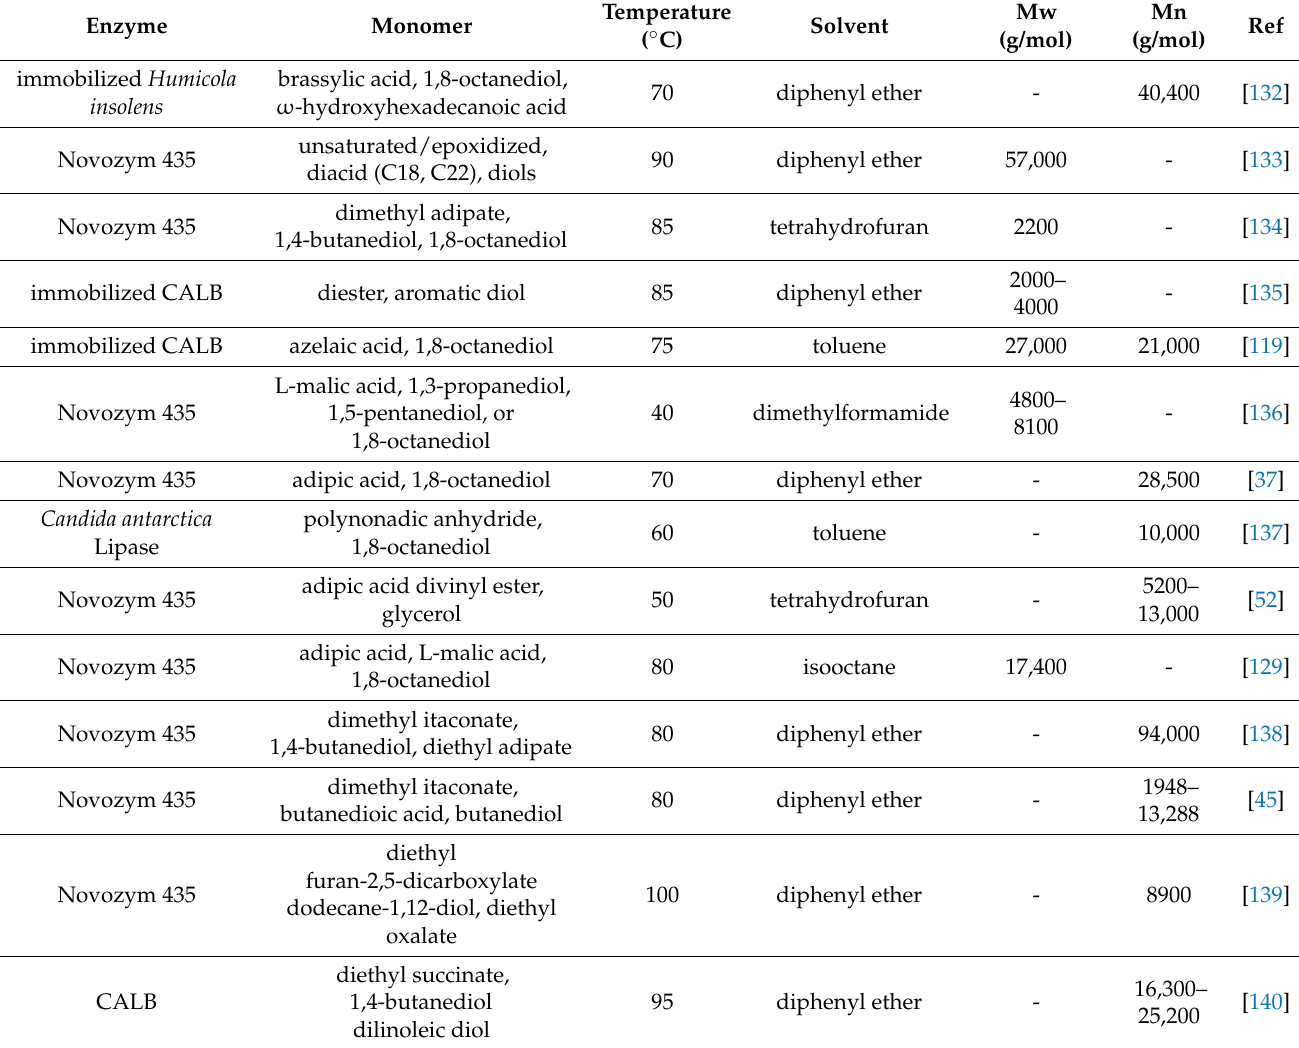
Table 2. Enzyme-catalyzed synthesis of polyesters in